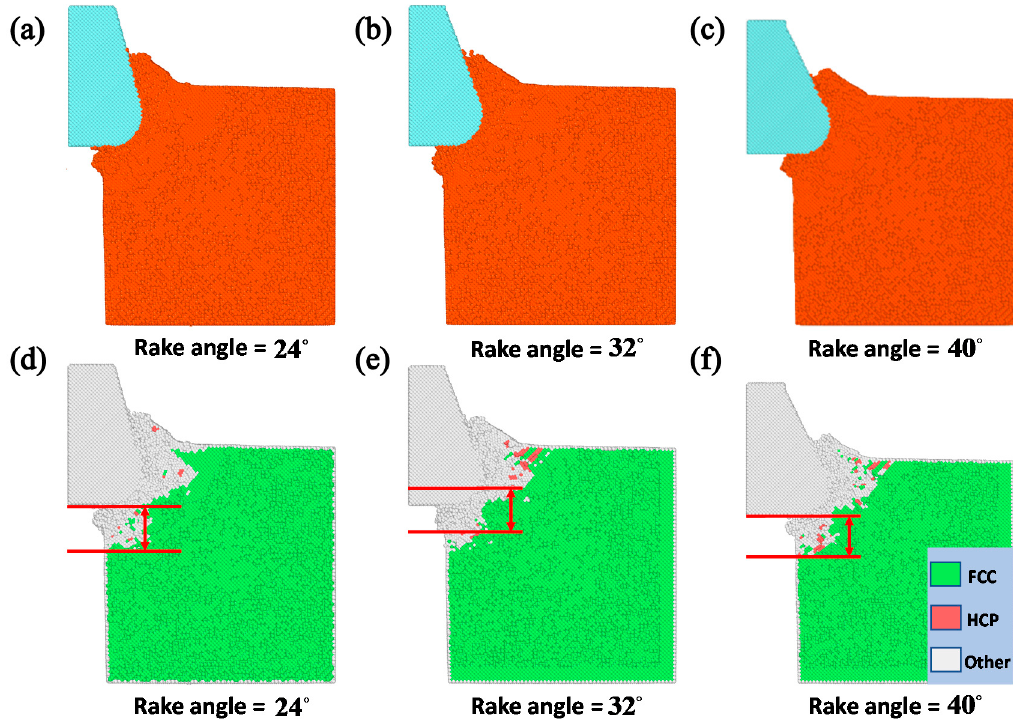
Figure 9. The atomic displacement and corresponding lattice distribution in the MD simulation at 200th step by varying the tool rake angle. ( a ) The atomic displacement when the rake angle = 24 ° ; ( b ) the atomic displacement when the rake angle = 32 ° ; ( c ) the atomic displacement when the rake angle = 40 ° ; ( d ) the corresponding lattice distribution when the rake angle = 24 ° ; ( e ) the corresponding lattice distribution when the rake angle = 32 ° and ( f ) the corresponding lattice distribution when the rake angle = 40 °.